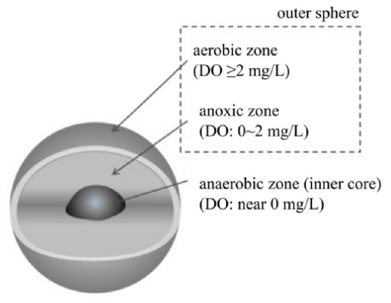
Figure 4. Division of DO concentration of AGS.